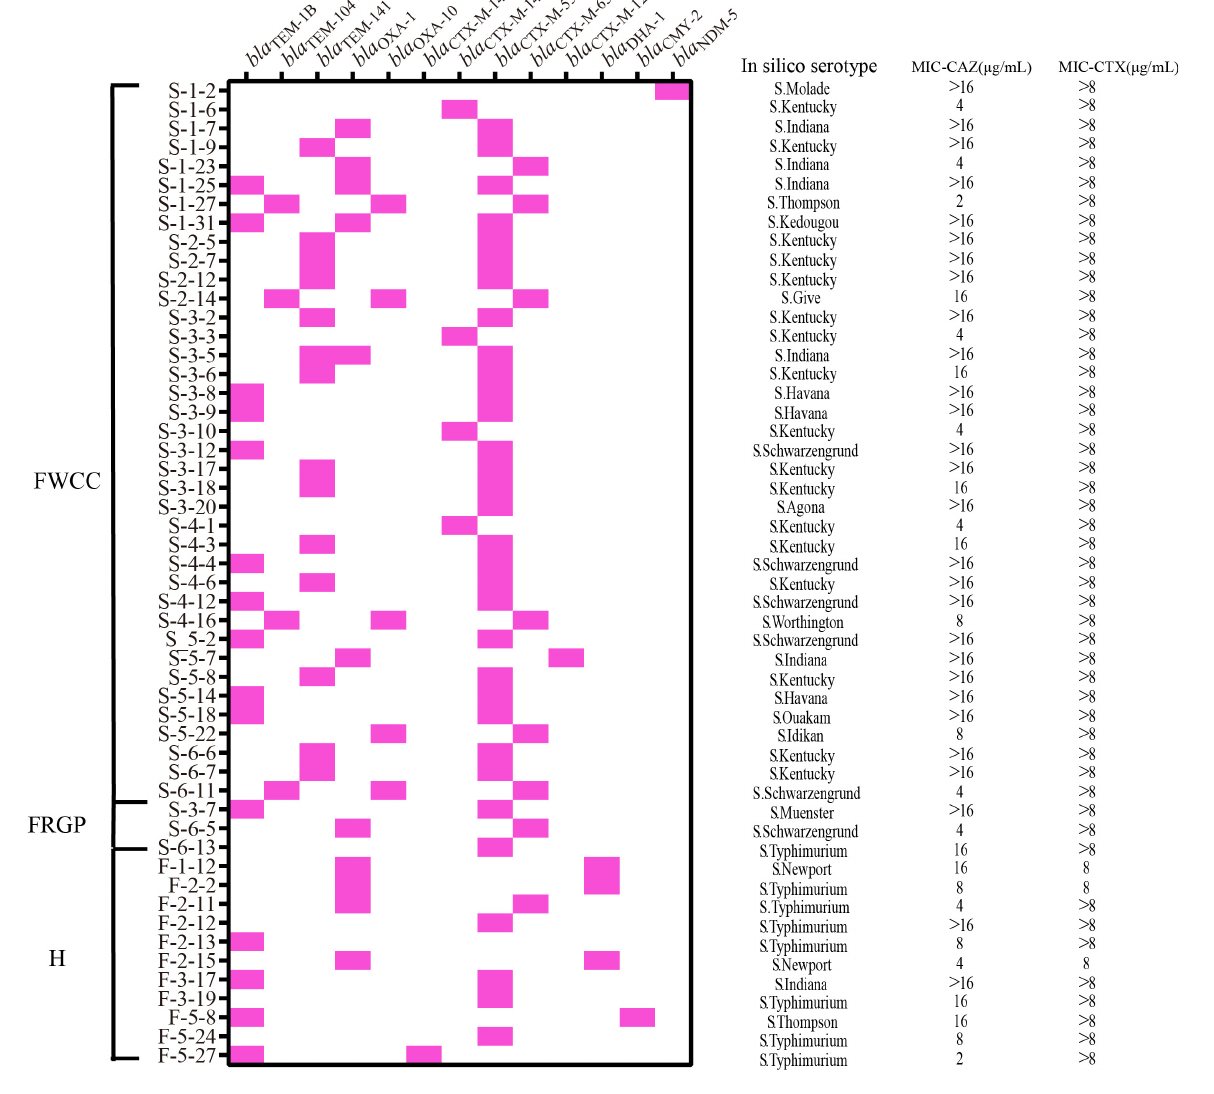
FIGURE 6 | Distribution of extended-spectrum β -lactamase (ESBL), AmpC and Carbapenemase β -lactamase genes, serotypes, minimal inhibitory concentration (MIC) of ceftazidime (CAZ), and MIC of cefotaxime (CTX) in the third-generation cephalosporin-resistant Salmonella isolates from different sources ( n = 52). H, human; FWCC, frozen whole chicken carcasses; FGRP, frozen raw ground